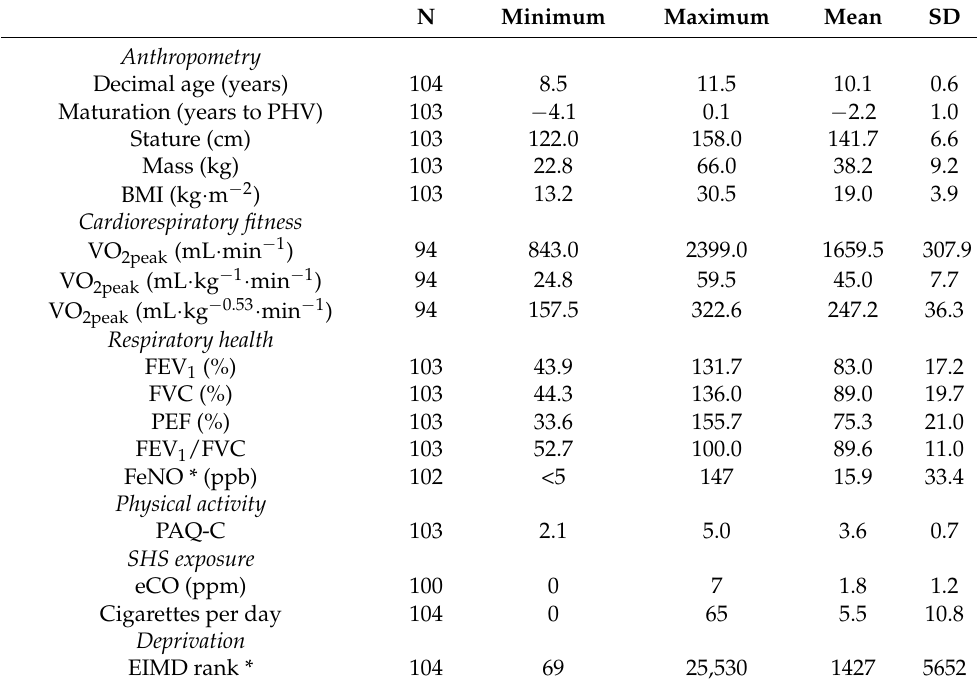
Table 1. Descriptive statistics for the